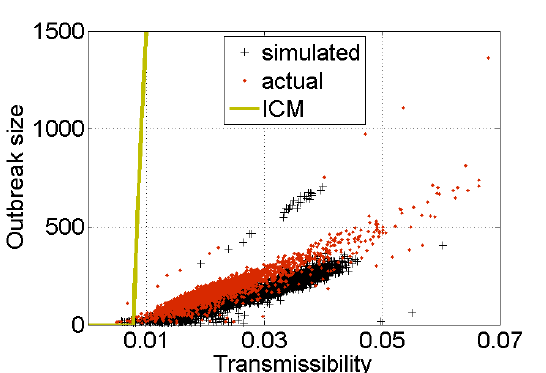
Figure 4. Size of simulated outbreaks on Digg as a function of transmissibility. Simulations of social contagion on the Digg follower graph ( black crosses ) using suppressed exposure response function suggested by Figure 3a. Actual outbreaks on Digg are shown as red dots, while theoretically predicted ( gold ) line is the same as in Figure 1. Suppressed response to repeated exposures vastly decreases the size of outbreaks as compared to prediction of the ICM (Figure